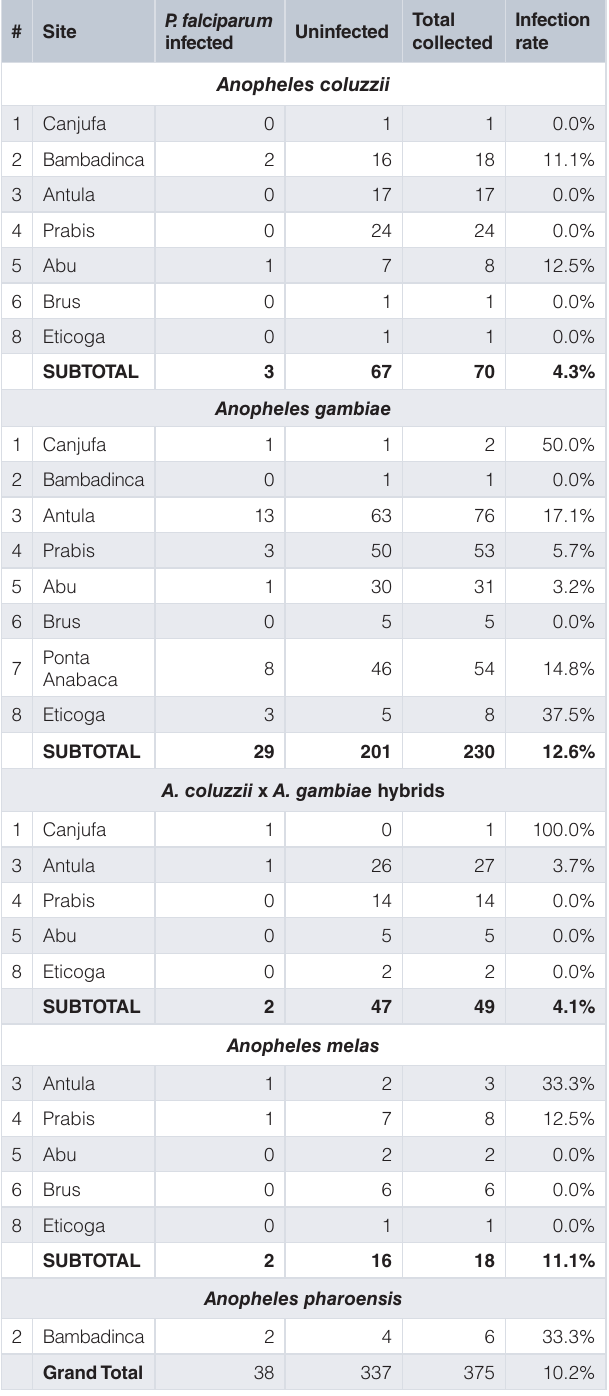
Table 1. Sites, species and Plasmodium falciparum circumsporozoite protein (CSP) detection information from Anopheles spp. samples collected in Guinea-Bissau, October and November 2009. Numbers (#) indicate site locations on the map of Guinea-Bissau in Figure 1. All mosquitoes were collected indoors with a single exception; samples in Ponta Anabaca were opportunistically collected